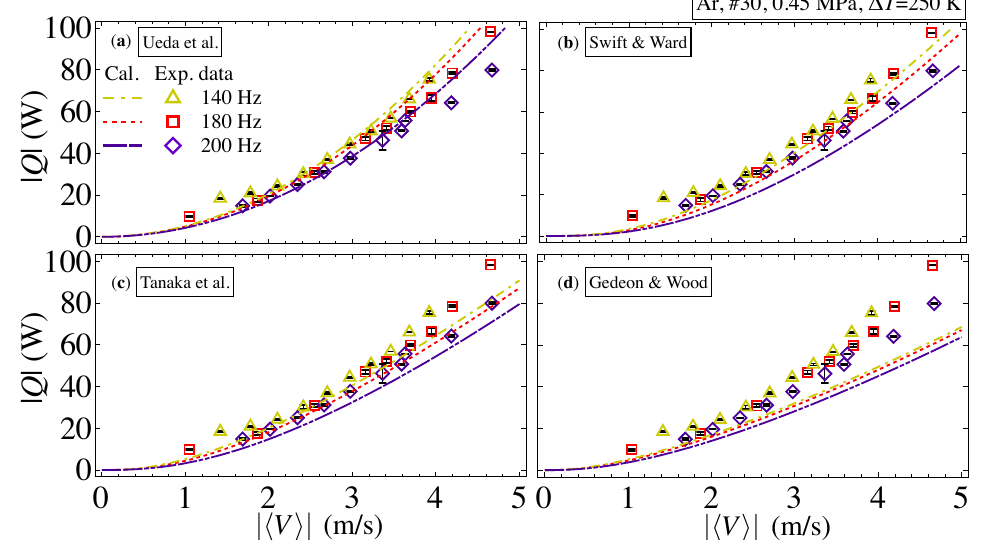
Q and predictions given by the empirical | |